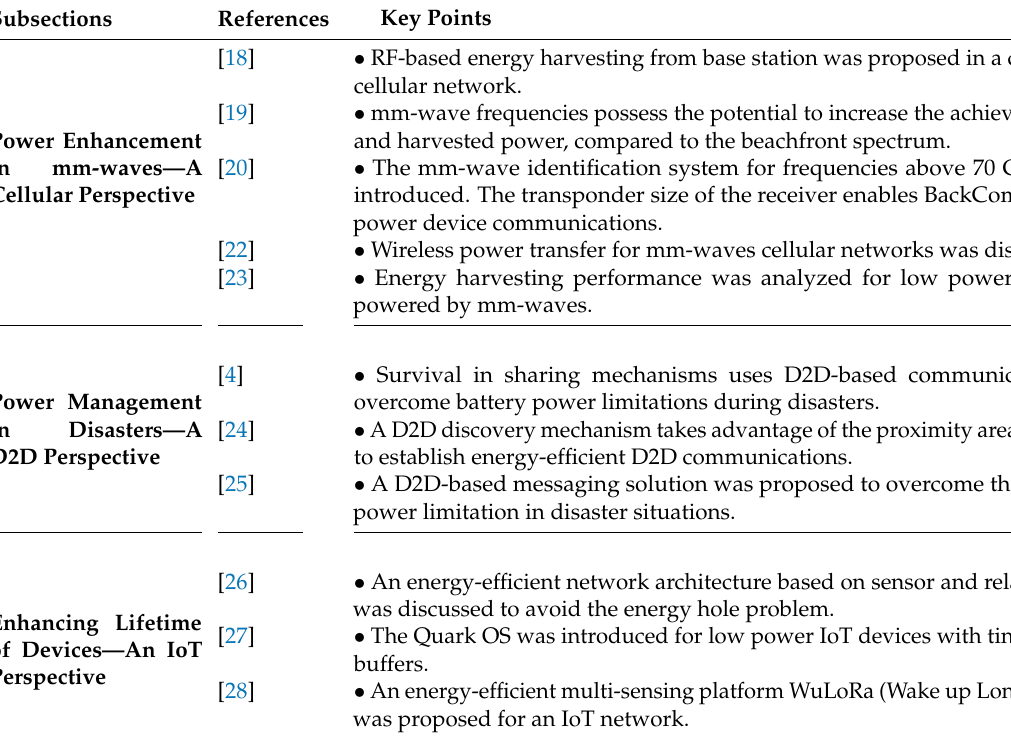
Table 1. Summary of energy constraints in wireless